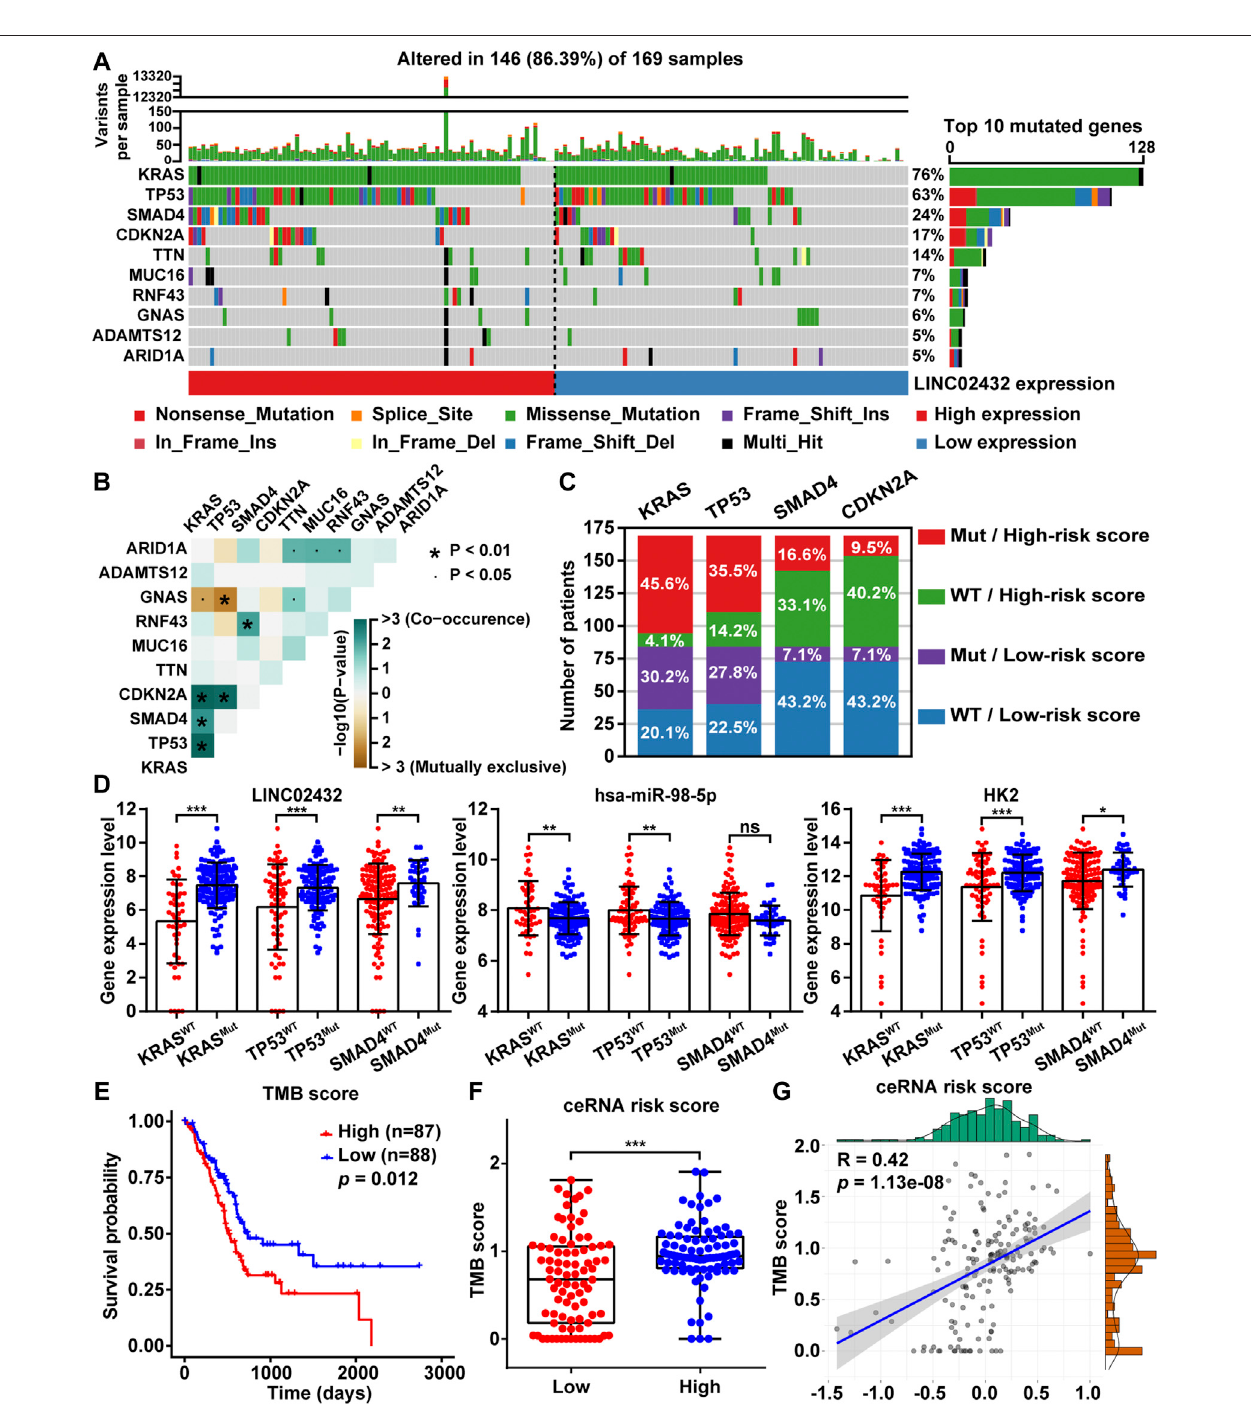
FIGURE 8 | The relationship between TMB and risk score. (A) The mutation signatures of the top 10 signi fi cant mutated genes in the high and low LINC02432 expression groups. (B) Theheatmapshowingthe co-occurrence and mutually exclusivemutations withinthe top 10frequently mutated genes. (C) Thedistribution ratio ofPAADpatients indifferentrisksubgroups. (D) Theexpression levels ofLINC02432,hsa-miR-98 – 5p,and HK2intheWTand Mutgroups ofKRAS, TP53,andSMAD4 genes. (E) Kaplan-Meier survival analysis for PAAD patients strati fi ed by TMB score. (F) TMB score between patients from the high and low ceRNA risk score subgroups. (G) The Pearson correlation analysis between risk score and TMB score.